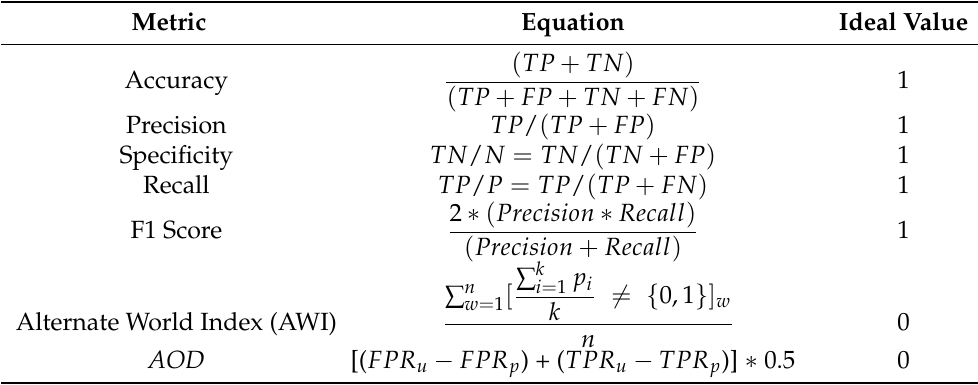
Table 2. Fairness and performance metrics. (Note: AOD represents AOD sex , AOD race , and AOD ethnicity ; FPR denotes false positive rate and TPR denotes true positive rate. The subscript U denotes underprivileged group and P denotes privileged group.) Metric Equation Ideal Value Accuracy